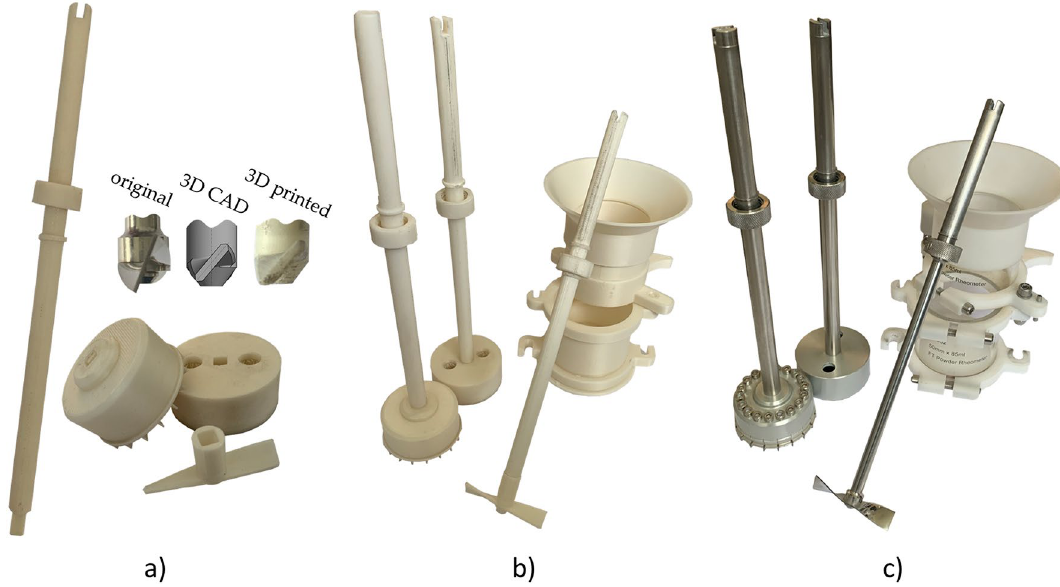
Figure 3. Design of FT4 instruments ( a ) FT4’s printed shaft, blade, vented piston, and shear head; ( b ) PLA printed FT4’s measuring set; ( c ) original FT4’s measuring set. This figure was created in Gimp